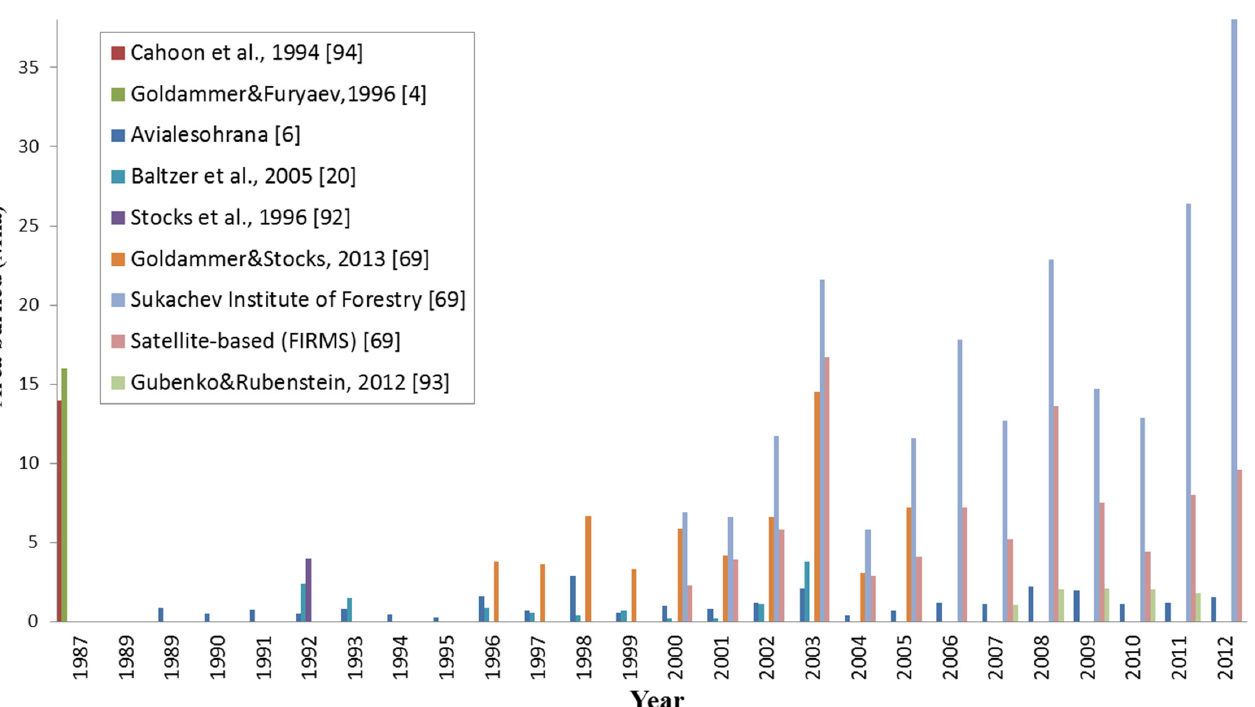
Figure 2. Forest area burned each year varies widely. Furthermore, there are great discrepancies in estimates of burned forest area conducted by different techniques (ground, aerial, satellite ‐ based, MFRI ‐ based). The Conard and Ivanova [3] estimate based on MFRI that annual area burned is 12 Mha (dashed line); Groisman et al. [81] suggest that 10 Mha (dotted line) of Russian forests burn annually; and Isaev et al. (2002) estimate an area in the range of 2–5.5 Mha (shaded band). Goldammer et al. [71] suggest that up to 3.4% of Russian forests (>30 Mha) can burn in a single year.